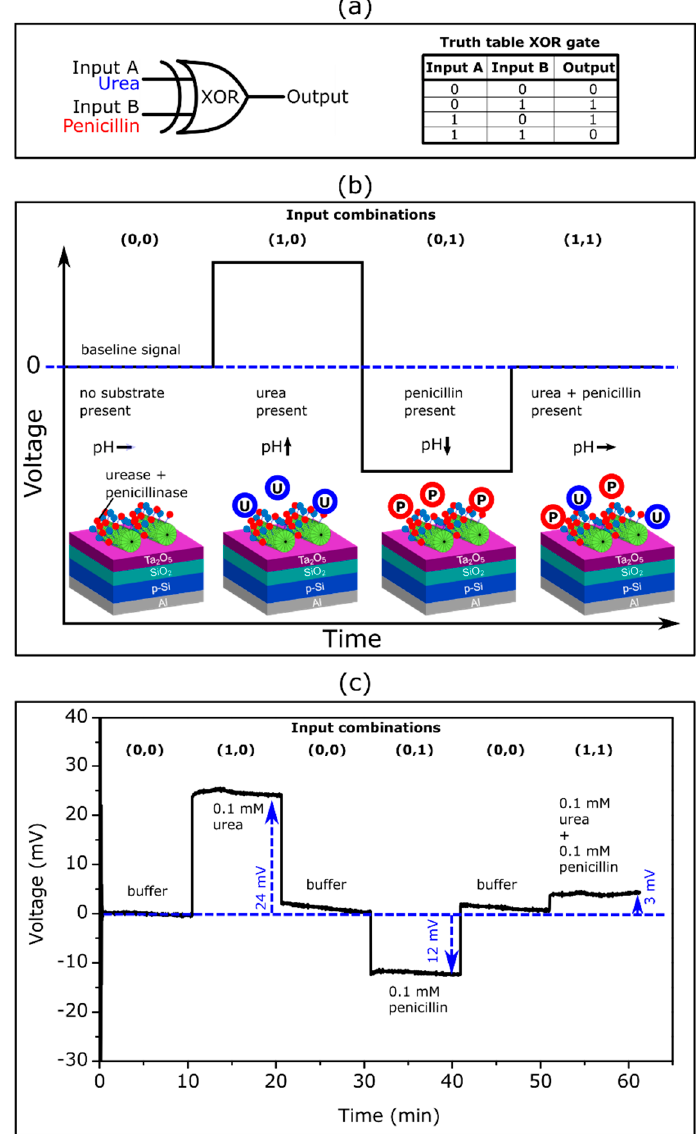
Figure 5. ( a ) Schematic symbol and truth table of an XOR gate with urea and penicillin as input signals. ( b ) Expected ConCap response for different input combinations. ( c ) Experimental ConCap curve of the TMV-assisted bi-enzyme EISCAP biosensor recorded in buffer (input combination ( 0 , 0 )), in 0.1 mM urea or penicillin solution (input combination ( 1 , 0 ) or ( 0 , 1 )) and in a mixture of 0.1 mM urea and 0.1 mM penicillin solution (input combination ( 1 , 1 )). U: urea, P: penicillin.